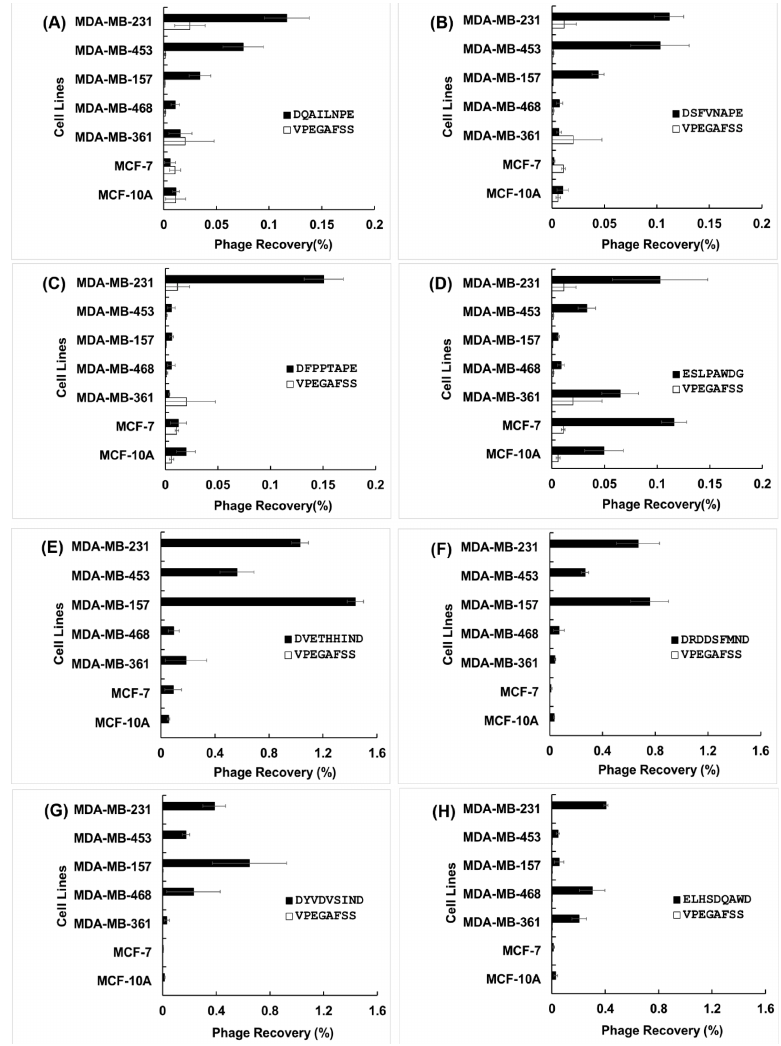
Figure 2. Selectivity of phages towards cancer cell lines. Binding of selected phages towards the target cell line, MDA-MB-231, in comparison with other cell lines derived from different breast cancer subtypes (MCF-7, MDA-MB-453, MDA-MB-157, MDA-MB-468, MDA-MB-361) and the phenotypically normal breast epithelial cell line (MCF-10A). ( A – D ) Phage clones selected from the f8/9 phage library and ( E – H ) phage clones selected from the f8/9 phage library. An unrelated phage bearing the peptide sequence VPEGAFSS was used as a negative control for each assay. Specificity of the phages were estimated as their percent recovery (%) = output phage / input phage ×